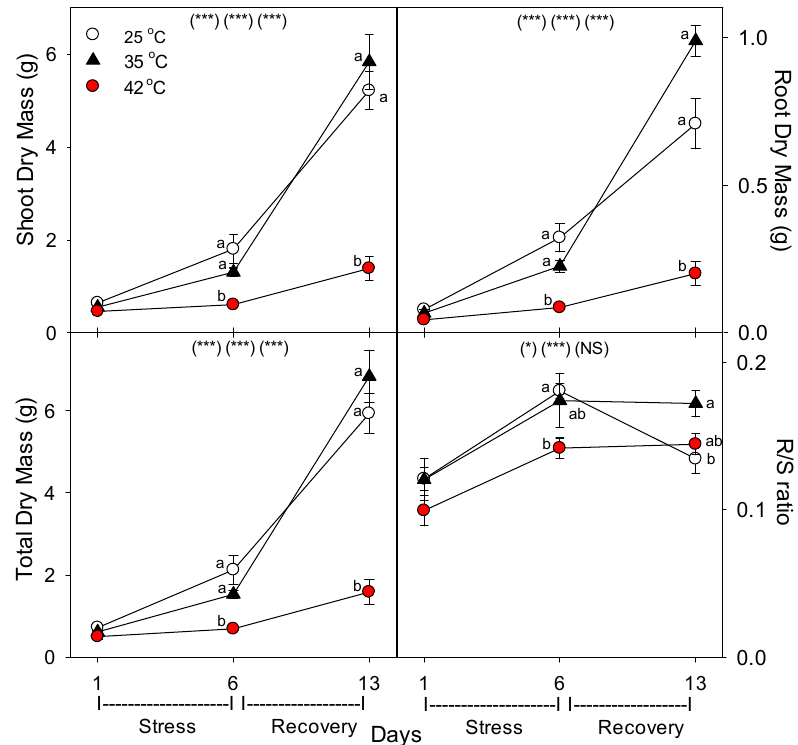
Figure 1. Effect of abrupt heat stress on biomass of tomato. Plants were grown at 25/20 °C day/night (control), and then subsets of plants were heat stressed at 35/30 or 42/37 °C day/night for one or six days (maximum root temperatures = 32 or 39 °C), and then returned to control conditions for seven days of recovery (=day 13). Values are means ± 1 SE for four independent replicates from each harvest (days 1, 6, 13). Within each variable, the significance of main treatment effects (temperature, day, temperature × day) is indicated in parentheses (* p < 0.05, ** p < 0.01, *** p < 0.001, NS = not significant). Different lowercase letters indicate significant difference among temperature treatments within each day.